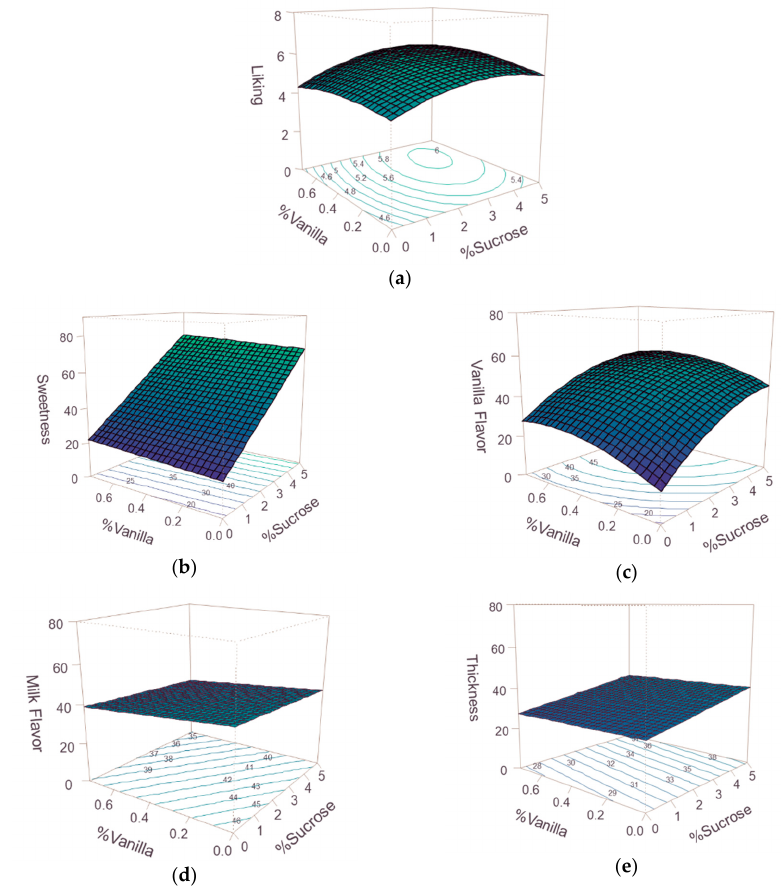
Figure 1. 3D response surfaces established from the 18 samples evaluated by 108 consumers, for all sensory response variables and sucrose (S) and vanilla (V) concentration. Dose-response functions are included for each surface: ( a ) overall liking OL = 4.40 + 0.669 · S + 1.42 · V + 0.198 · S · V − 0.102 · S 2 − 2.05 · V 2 ; R 2 = 0.11, F(5, 1938) = 47.92, p < 0.05; ( b ) perceived sweetness SW = 18.1 + 10.5 · S + 5.11 · V; R 2 = 0.37, F(2, 1941) = 567.5, p < 0.05; ( c ) perceived vanilla flavor VF = 13.8 + 11.3 · S + 50.6 · V − 1.17 · S − 1.07 · S 2 − 42.6 · V 2 ; R 2 = 0.21, F(5, 1938) = 104.7, p < 0.05; ( d ) perceived milk flavor MF = 46.9 − 1.04 · S − 10.4 · V; R 2 = 0.02, F(2, 1941) = 16.24, p < 0.05; and ( e ) perceived thickness TH = 29.4 + 1.97 · S − 2.42 · V; R 2 = 0.02, F(2, 1941) = 23.2, p <